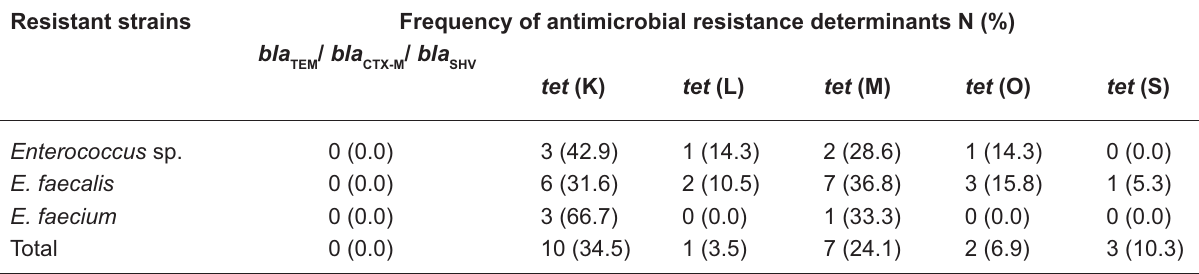
Table 3- Distribution of tetracycline, ampicillin and gentamicin resistance genes in enterococci resistant to these Resistant strains